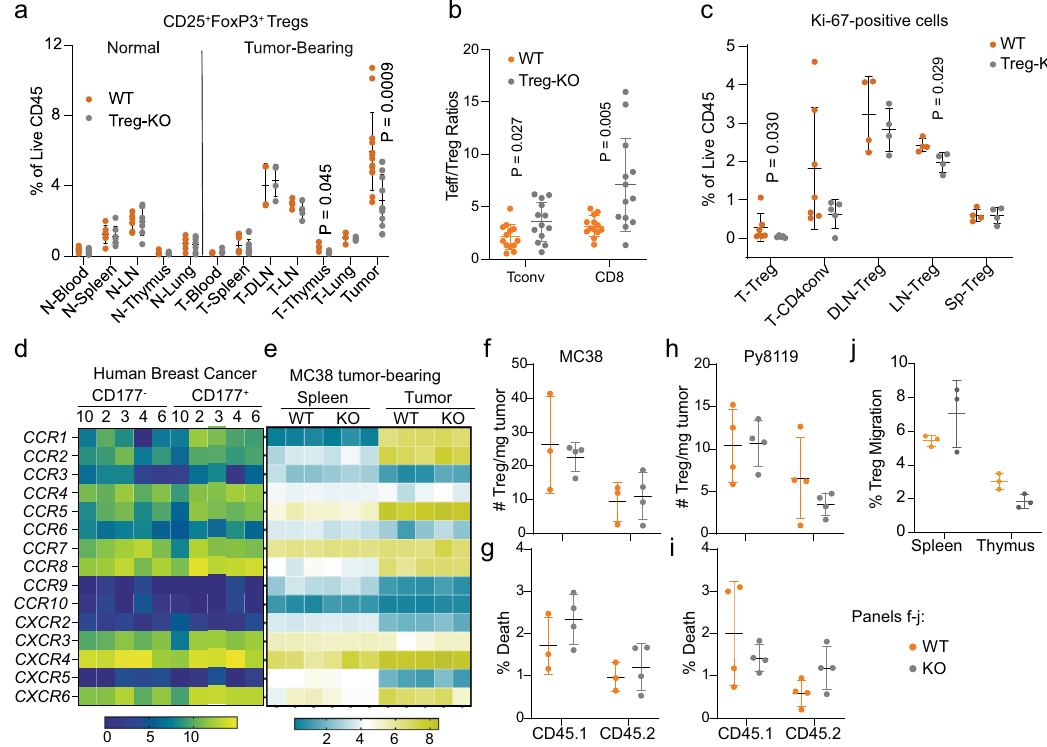
Fig. 6 Cd177 -de fi ciency in Treg cells leads to reduced frequency of TI Treg cells. a Impact of Treg-speci fi c Cd177- KO on the frequency of Treg cells within different tissues of normal or MC38-tumor-bearing mice ( n = 6 for normal WT and n = 7 for KO mice; n = 13 for tumor TI-Treg cells and n = 4 for other tissues from tumor-bearing mice, T: tumor. b The ratios between TI Teff cells – including CD4 Tconv and CD8 T cells – and TI Treg cells in MC38 Tumors ( n = 13 biological repeats). c Percentage of Ki-67 + T cells relative to total CD45 + leukocytes within different tissues from WT or Treg-speci fi c Cd177- KO mice bearing MC38 tumors. Tissues were from similar experiments as in Fig. 5c tumor bearing mice ( n = 7 WT and 5 Treg-KO). P -values are indicated when less than 0.05. T, tumor; DLN, draining lymph nodes; LN, non-draining lymph nodes; Sp, Spleen. d , e Heatmap showing gene expression of chemokine receptors within CD177 + and CD177 − TI Treg cells, using fl ow-sorted CD177 + and CD177 − TI Treg cells from 5 human breast cancer specimens ( d data adapted from GSE89225 with patient number included), or RNA sequencing of splenic or TI Treg cells from MC-38 tumor bearing WT or Treg-speci fi c Cd177 -KO mice ( e GSE150420, n = 3 each group; tumor KO group, n = 2). f – i Impact of CD177 on Treg recruitment into tumors. Splenic and thymic Treg cells (1:1 combined) from WT or germline CD177-KO mice of C57BL/6 background were puri fi ed (CD4 + CD25 + GITR + ) and adoptively transferred into tumor-bearing congenic CD45.1 mice ( f – g MC38; h – i Py8119). The frequency ( f , h the number of Treg cells per mg tumor tissues) or viability ( g , i